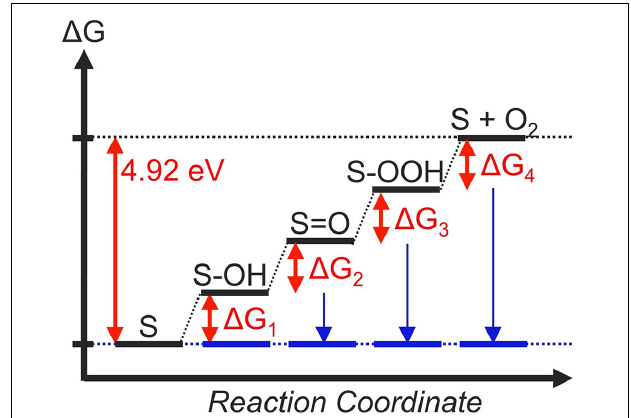
FIGURE 2 | The thermodynamic landscape of an ideal OER catalyst at U = 0 V (black lines) and U = 1.23 V (blue lines). Relative energies are indicated in red letters.